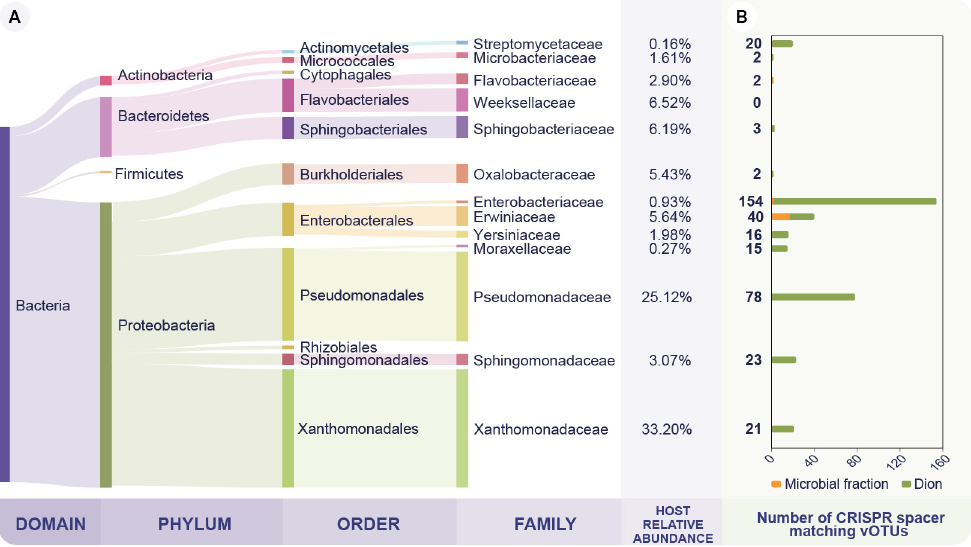
Figure 2. Microbial taxonomic profile and CRISPR-based vOTU host taxonomy assignment. ( A ) Rel- ative abundance of the dominant bacterial families on the bacterial fraction. Taxonomy was assessed at the read level from the microbial fraction samples (FL mf and PL mf ). ( B ) Host prediction performed by matching the vOTUs against CRISPR spacers either from the Dion CRISPR-spacer database or from the assembled microbial contigs. The y-axis represents bacterial families and the x-axis the number of vOTUs predicted to infect such family. Notably, Moraxellaceae and Streptomicetaceae are not highly abundant families in the microbial fraction. However, they were included in the fig- ure, since ≥ 15 vOTUs were predicted to infect these bacterial families.